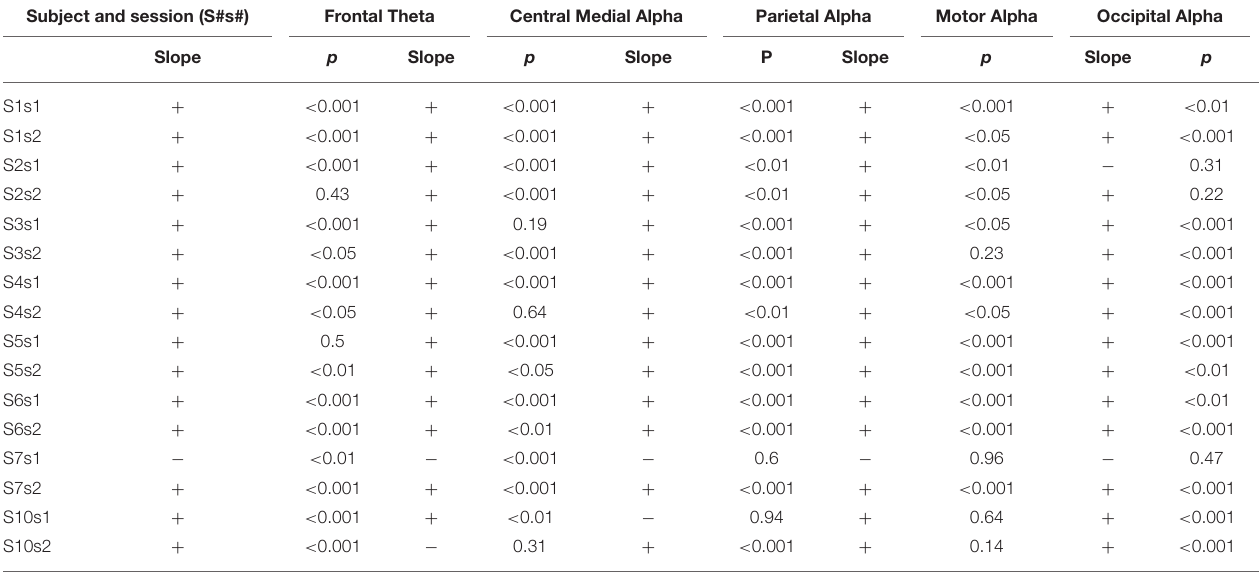
TABLE 2 | Summary of linear regression analysis of IC power dynamics at corresponding dominant frequency bands of each session at each subject. Subject and session